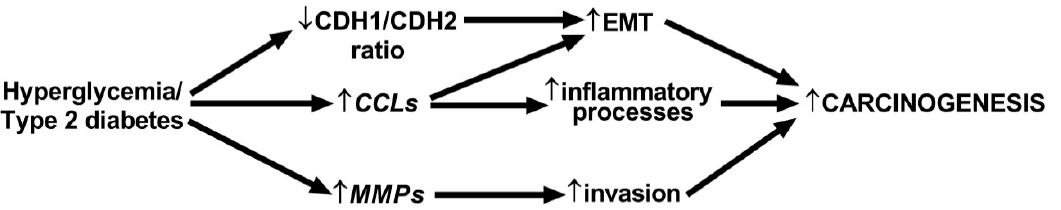
Figure5. Proposedcarcinogenicmechanismoftheobservedchangesattranscriptlevelsinprostatetissue Figure 5. Proposed carcinogenic mechanism of the observed changes at transcript levels in prostate of patients with type 2 diabetes. CDH1: E-cadherin; CDH2: N-cadherin; EMT: epithelial-mesenchymal tissue of patients with type 2 diabetes. CDH1: E-cadherin; CDH2: N-cadherin; EMT: transition; CCLs: CCL chemokine ligands; MMPs: matrix epithelial-mesenchymal transition; CCLs: CCL chemokine ligands; MMPs: matrix metalloproteinases.